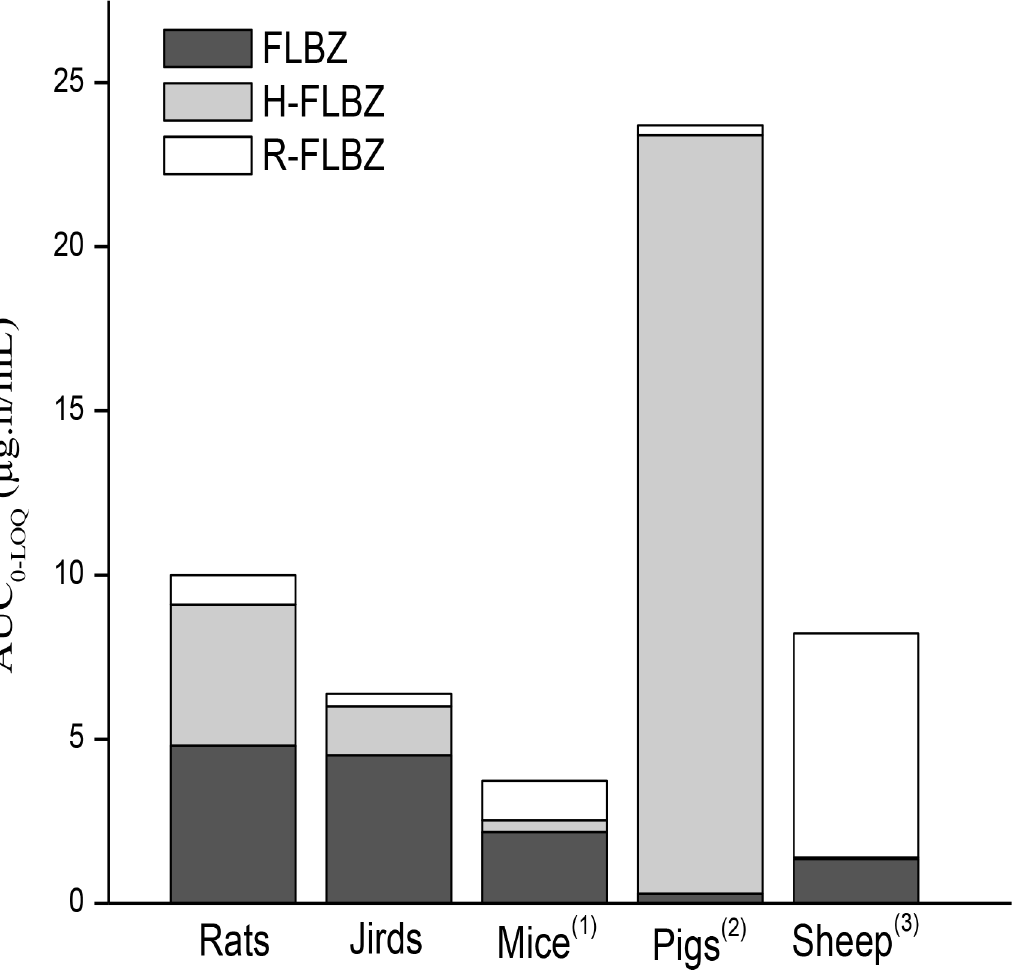
Figure 5. Relative systemic exposure (area under concentration vs. time curve, AUC 0-t ) of flubendazole (FLBZ) and its reduced (R- FLBZ) and hydrolyzed (H-FLBZ) metabolites in different animal species treated orally with a FLBZ-CD solution. Data taken from Ceballos et al, 2009 (1), 2012 (a) (2), 2012 (b) (3). doi:10.1371/journal.pntd.0002838.g005 PLOS Neglected Tropical Diseases |